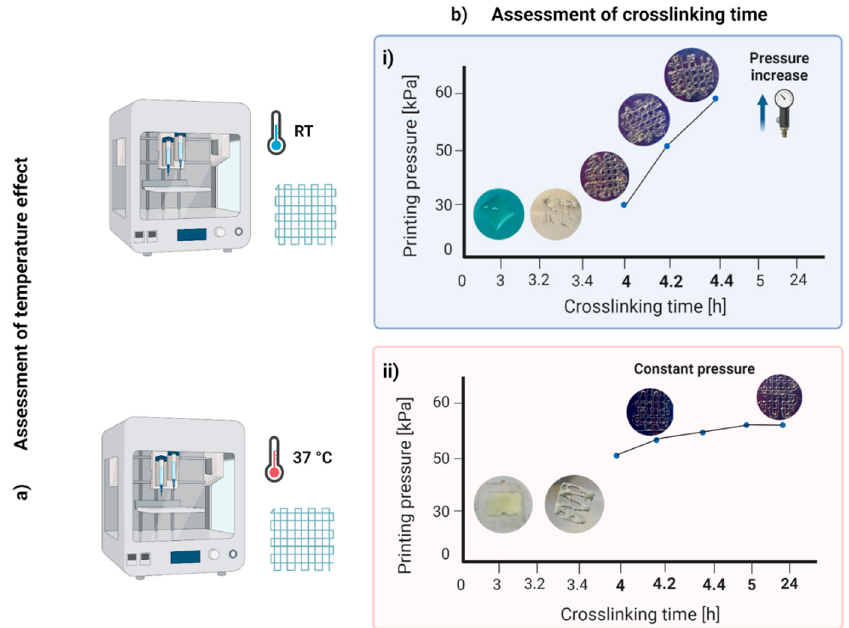
Figure 1. Layer-stacking or -merging results: assessment of ( a ) temperature and ( b ) cross-linking time effect. ( i ) The hybrid hydrogel printed at room temperature (RT) was suitable for printing from 4 to 4.4 h after the addition of the Star-PEG-MA; ( ii ) hybrid hydrogel printed at 37 °C was suitable for printing from 4 to 24 h after the addition of the Star-PEG-MA.